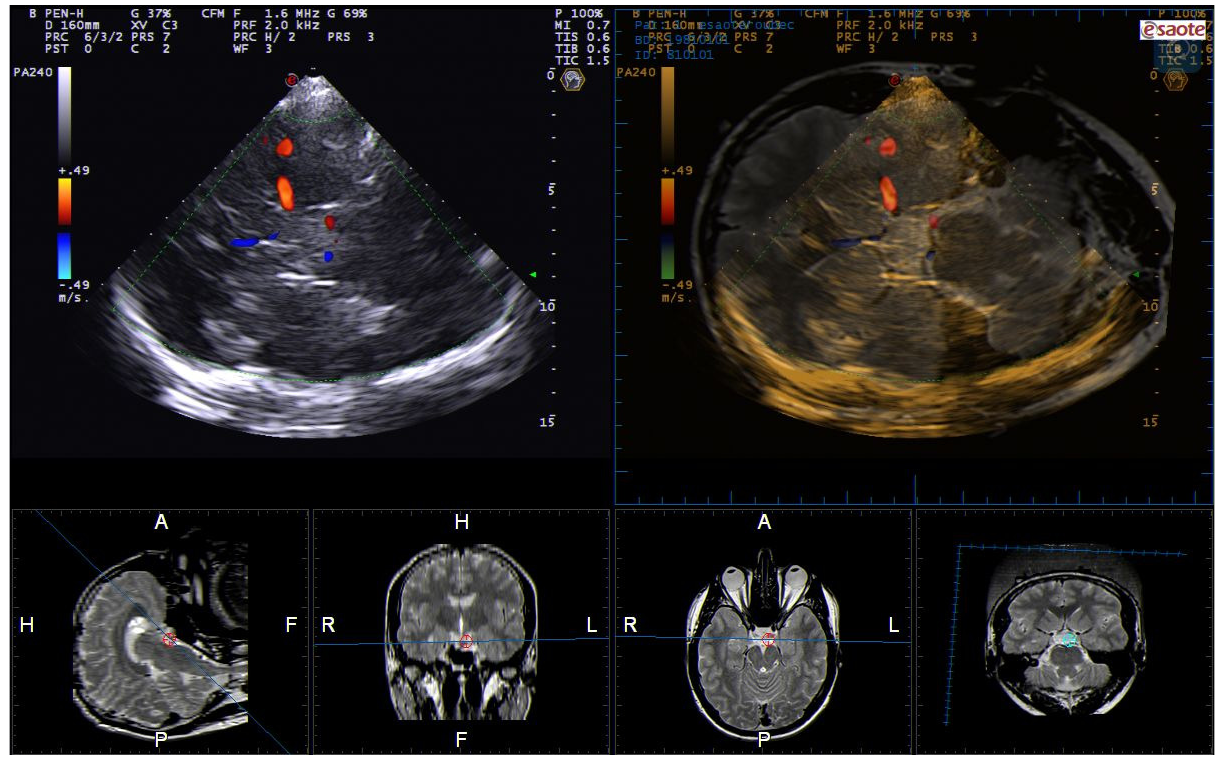
Fig. 1. Fusion Imaging of brain MRI and TCCS